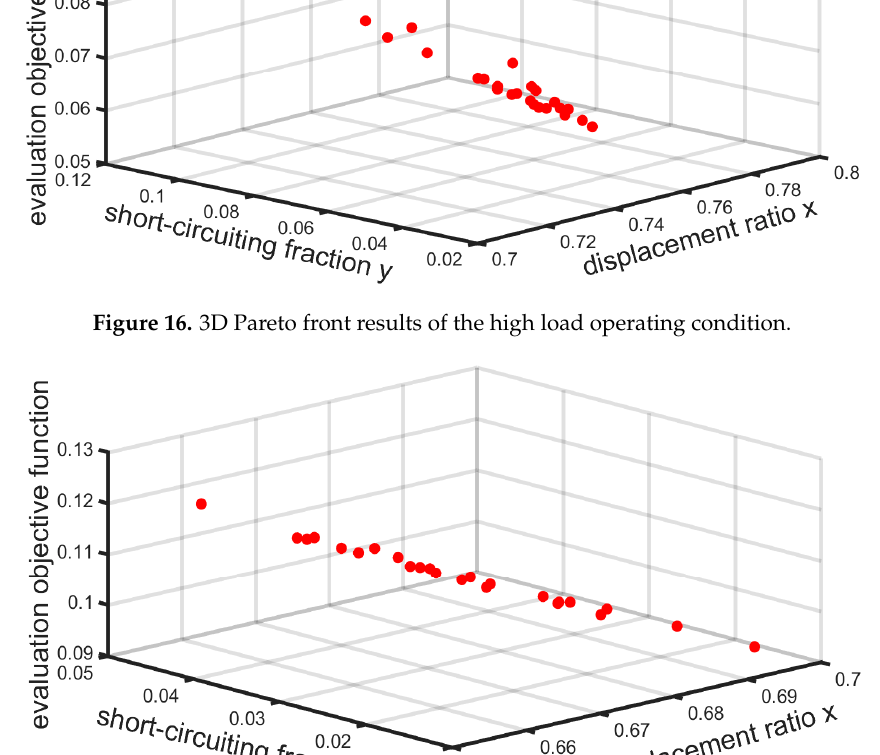
Figure 17. 3D Pareto front results of the partial load operating condition.